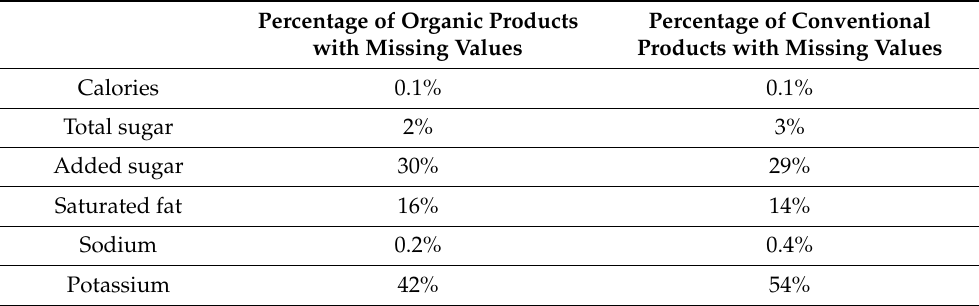
Table 1. Frequency of missing nutrient values for specific nutrients, by percentage of the total of 8240 organic and 72,205 conventional products. Percentage of Organic Products Percentage of Conventional with Missing Values Products with Missing Values Calories 0.1% 0.1% Total sugar 2% 3% Added sugar 30% 29% Saturated fat 16% 14% Sodium 0.2% 0.4% Potassium 42% 54%